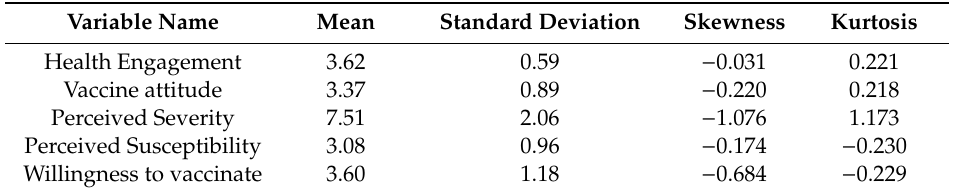
Table 2. Descriptive statistics.